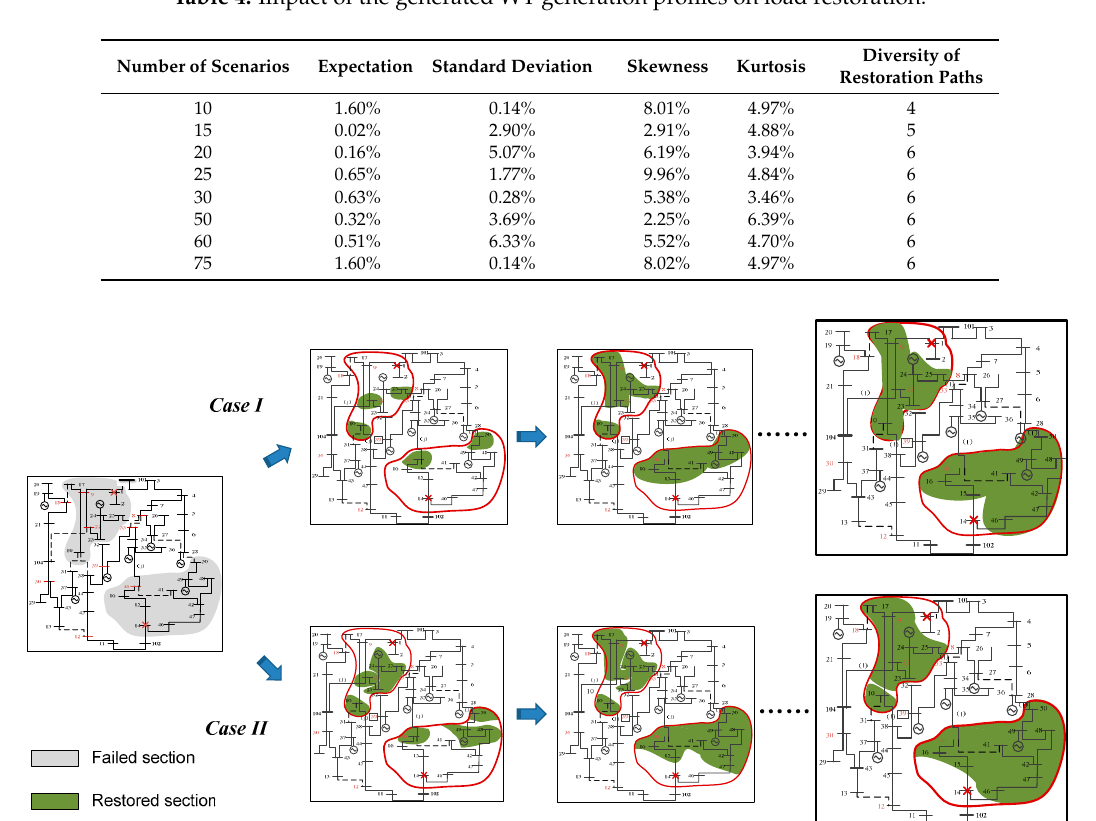
Table 4. Impact of the generated WT generation profiles on load restoration.